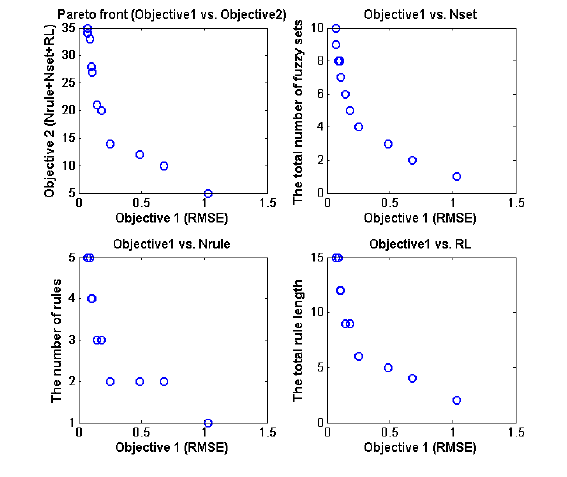
Fig. 7. The Pareto fronts obtained by using Fig. 8 and 9 only show the results of IMOFM_M.